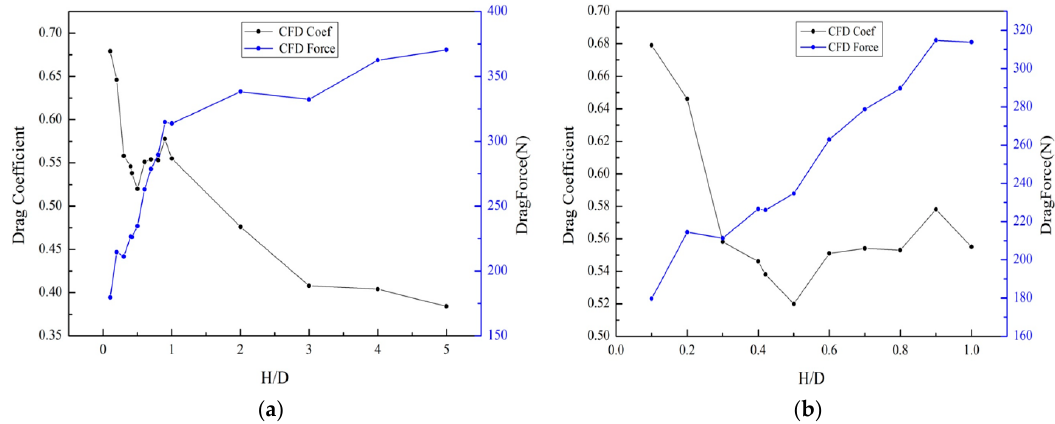
Figure 7. Time averaged drag coefficient and drag force with different aspect ratios: ( a ) the whole figure; ( b ) the partial enlargement figure.